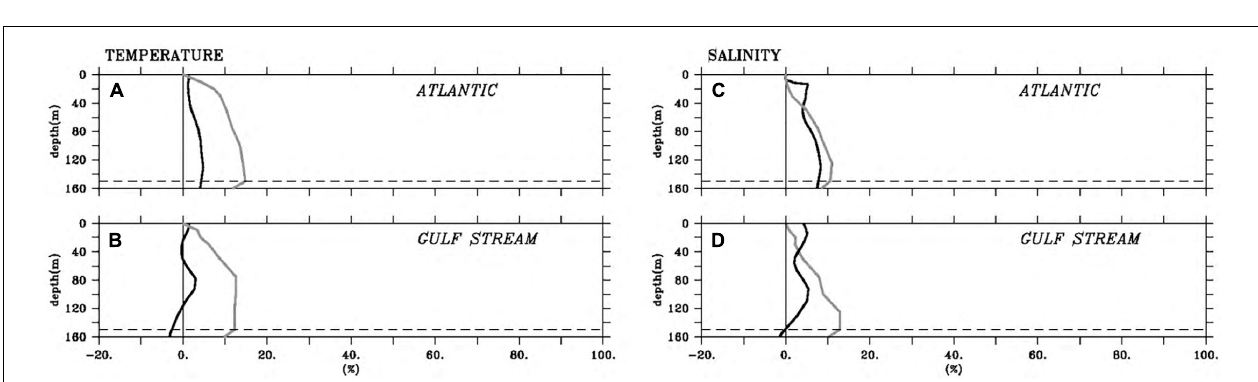
FIGURE 6 | Same as Figure 5 , but for the top-to-bottom profiles of MSE reduction for the DEEP experiment as compared with the BACKBONE experiment.